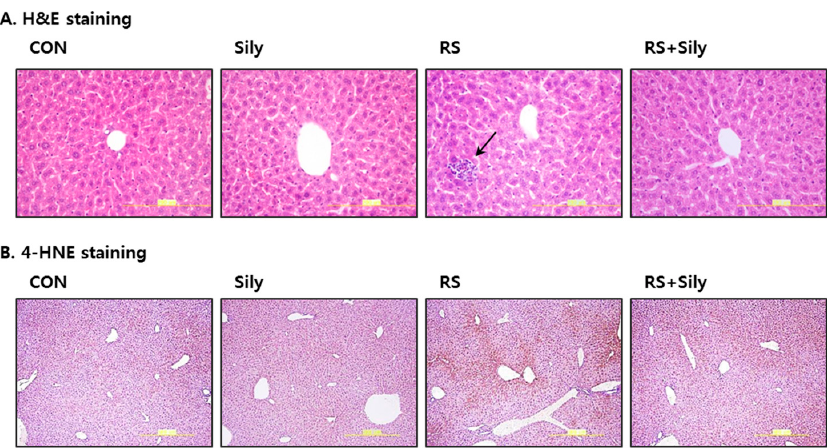
Figure 2. Effect of silymarin on histological changes of the liver in mice subjected to restraint stress. ( A ) Hematoxylin and eosin (H & E) staining of representative liver sections shown at the same magnification (400×). Only mice subjected to restraint showed infilterated cells in the liver parenchyma. Black arrow represents inflammatory cell infiltration; ( B ) Representative pictures of 4-HNE protein adducts with brown color. 4-HNE positivity was observed mostly in hepatocytes around the central vein and it was most clear in the liver of restraint stressed mice. (CON; control mice, Sily; only silymarin-treated mice, RS; restraint stressed mice, RS + Sily; restraint-stressed mice with silymarin treatment).